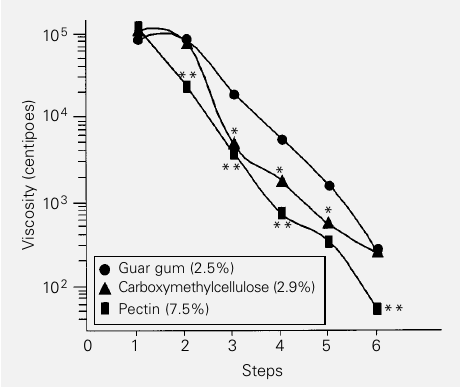
Figure 1 - Effect of temperature, hydration, acidification and reneutralization at a shear rate of 10 rpm on the viscosity measurements of the viscous polysaccharides guar gum, carboxymethylcellulose and pectin. Step 1: 22 o C; step 2: 37 o C; step 3: one hour acidification with 200 ml of a 0.1 M HCl, 54 mM KCl solution; step 4: second hour acidification with 400 ml of a 0.1 M HCl, 54 mM KCl solution; step 5: third hour acidification with 600 ml of a 0.1 M HCl, 54 mM KCl solution; step 6: one hour reneutralization with a 120 mM NaHCO 3 + 5 mM KCl + 30 mM NaCl solution. *P<0.01 and **P<0.001 compared to guar gum ( t -test for unpaired